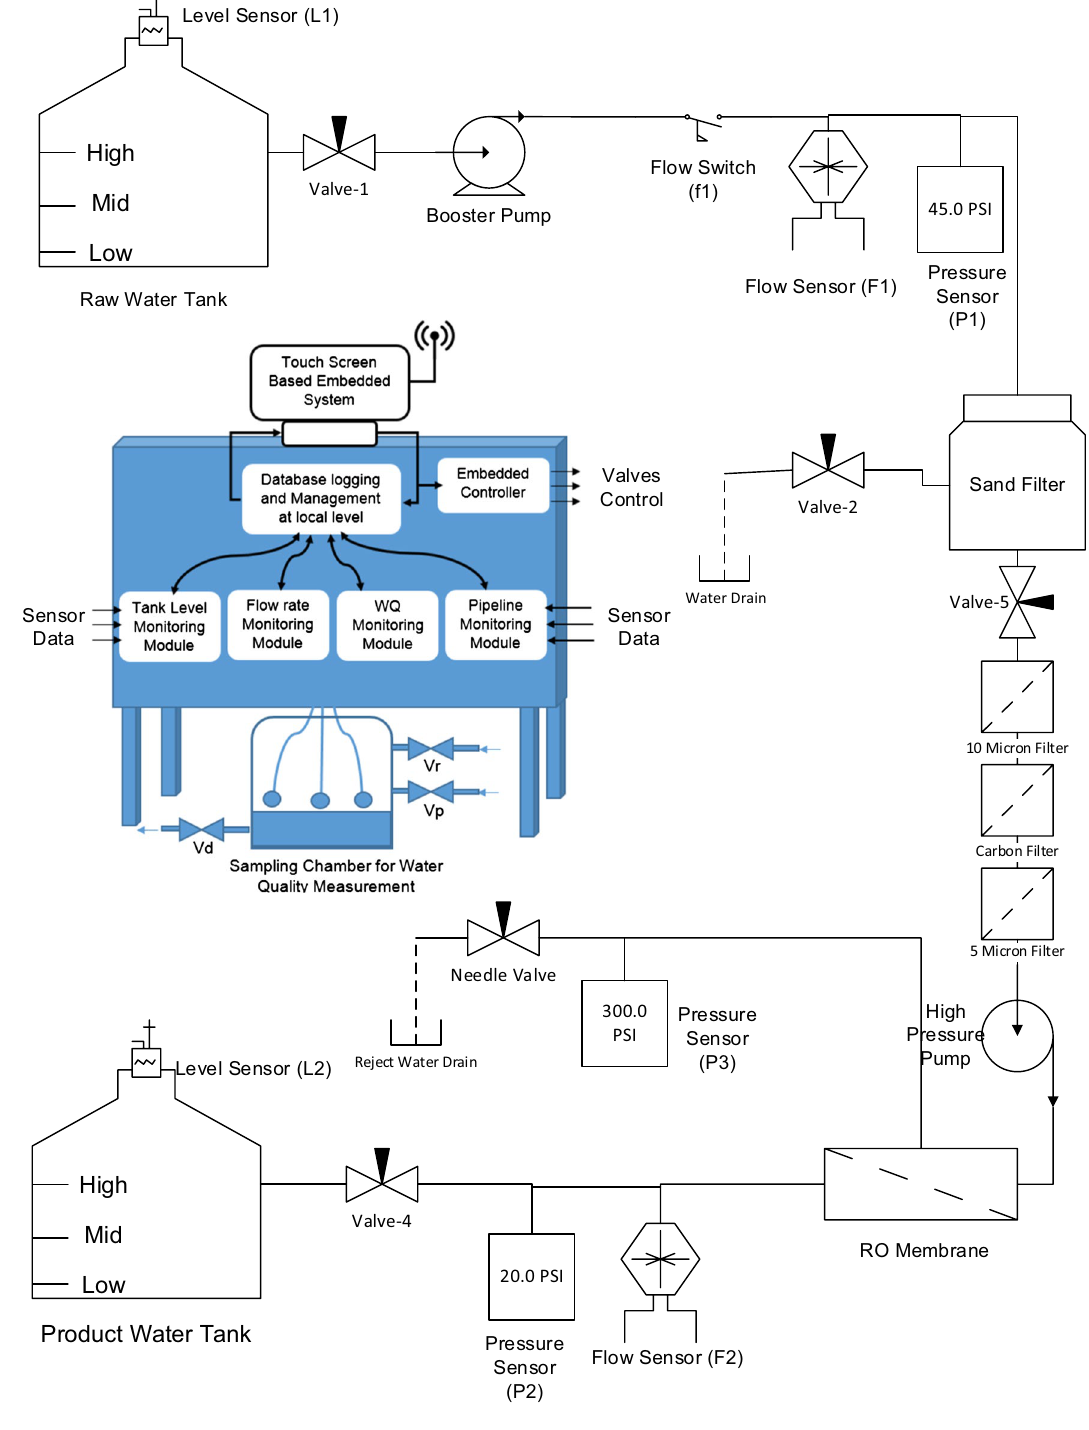
Fig. 4 Line diagram of reverse osmosis plant status monitoring unit integrated with reverse osmosis